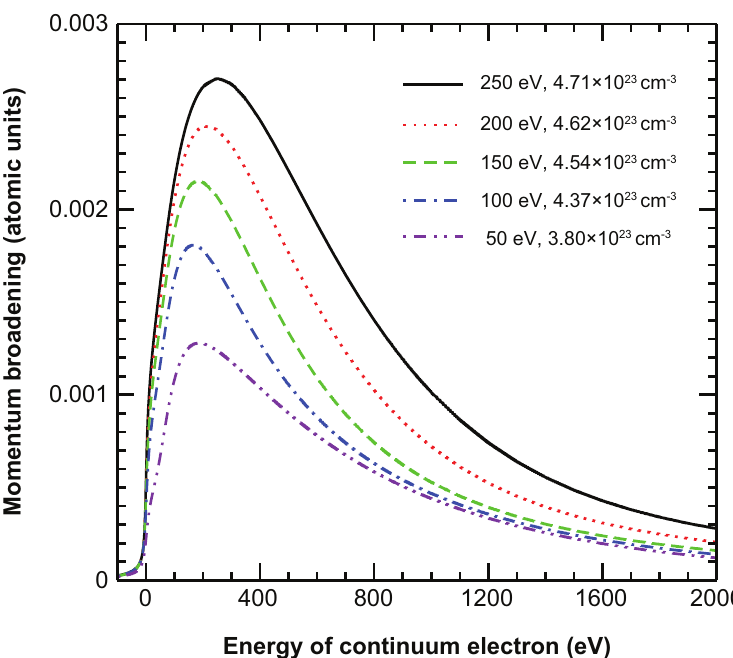
Figure 3. Momentum broadening of the continuum electrons. The continuum electrons are ejected from collisional ionization, e + 1 s 2 2 s 2 S → 1 s 2 1 S + 2 e of Mg 9 + , occurring in a solid-density magne- sium plasma at plasma temperatures of 250 eV (solid black line), 200 eV (dotted red line), 150 eV (dashed green line), 100 eV (dot-dashed blue line), and 50 eV (dot-dot-dashed violet line). Atomic units are used for the half-widths at half-maximum in the momentum